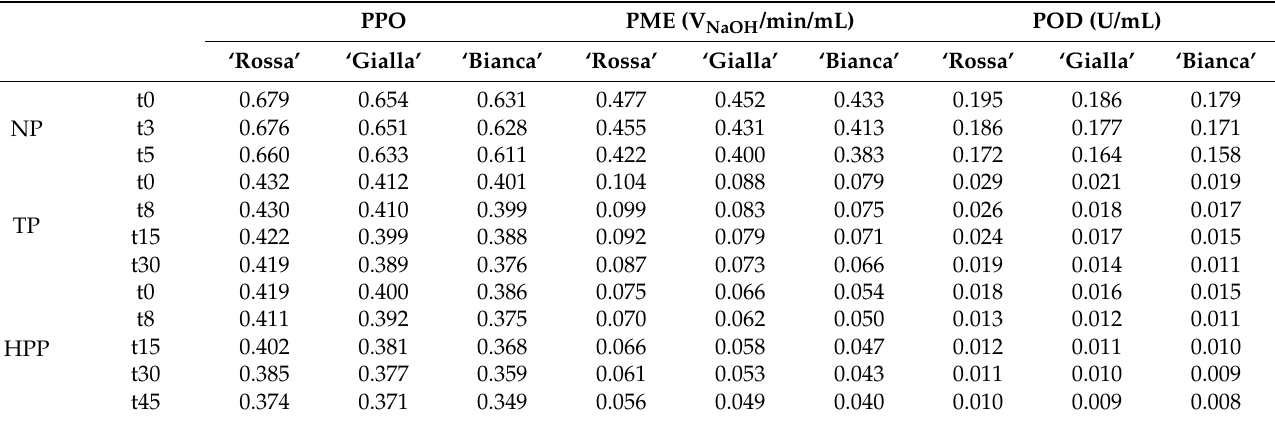
Table 3. Variation in the enzymatic activity of polyphenol oxidase (PPO), peroxidase (POD),